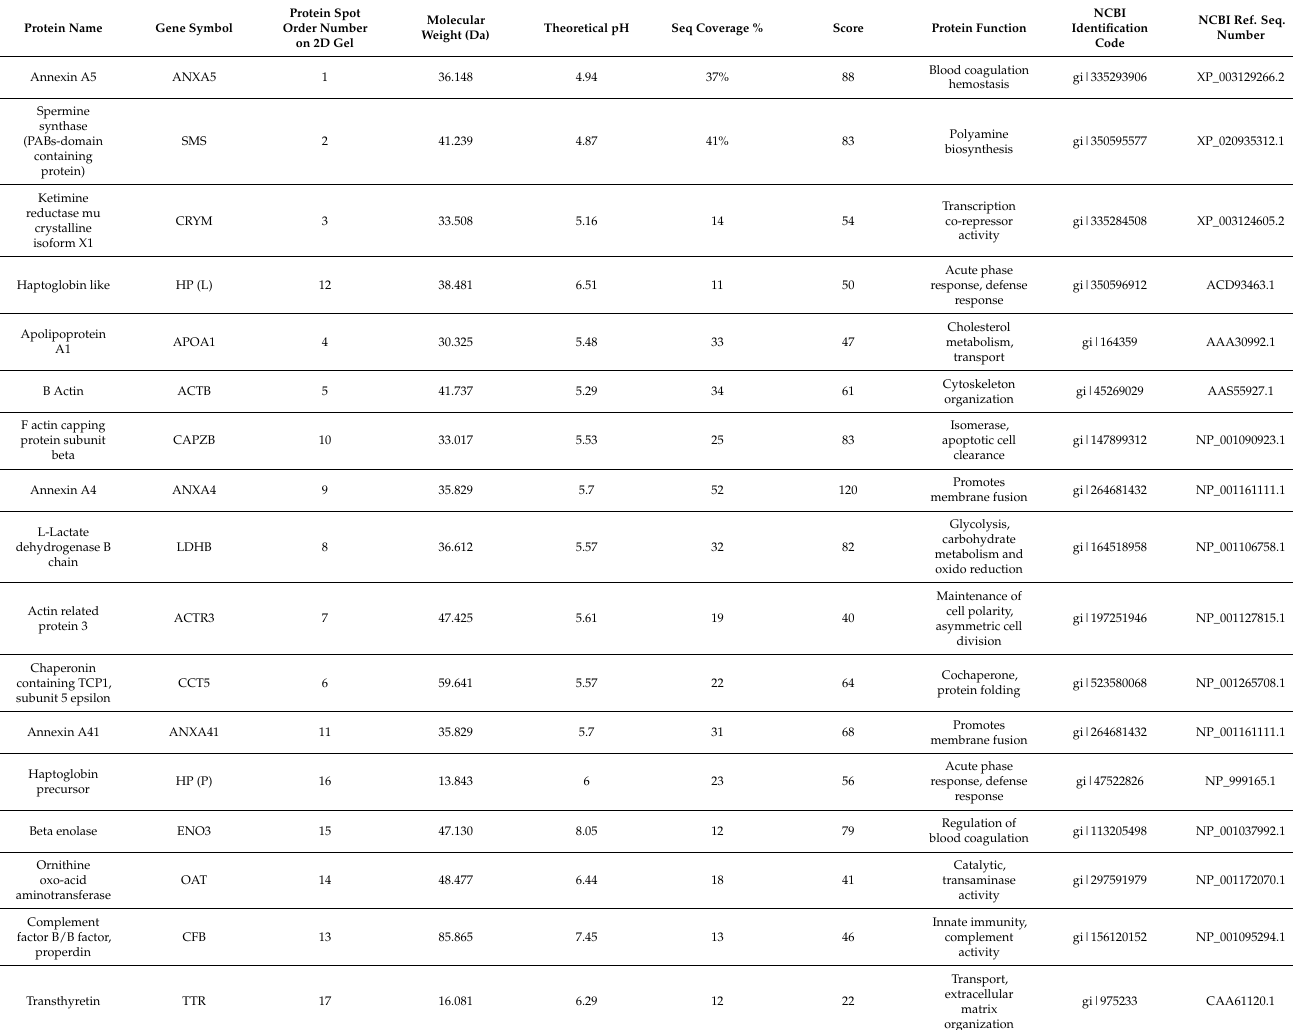
Table 1. Characteristic of identified proteins differentially expressed in uterine endometrial tissue during 9D, 12D, and 16D of pregnancy in PLW